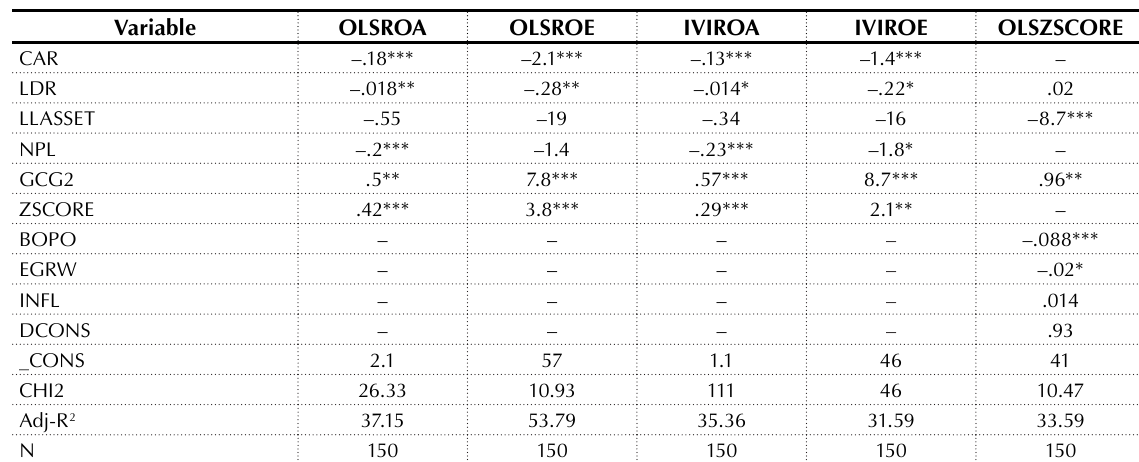
Table 3. The results